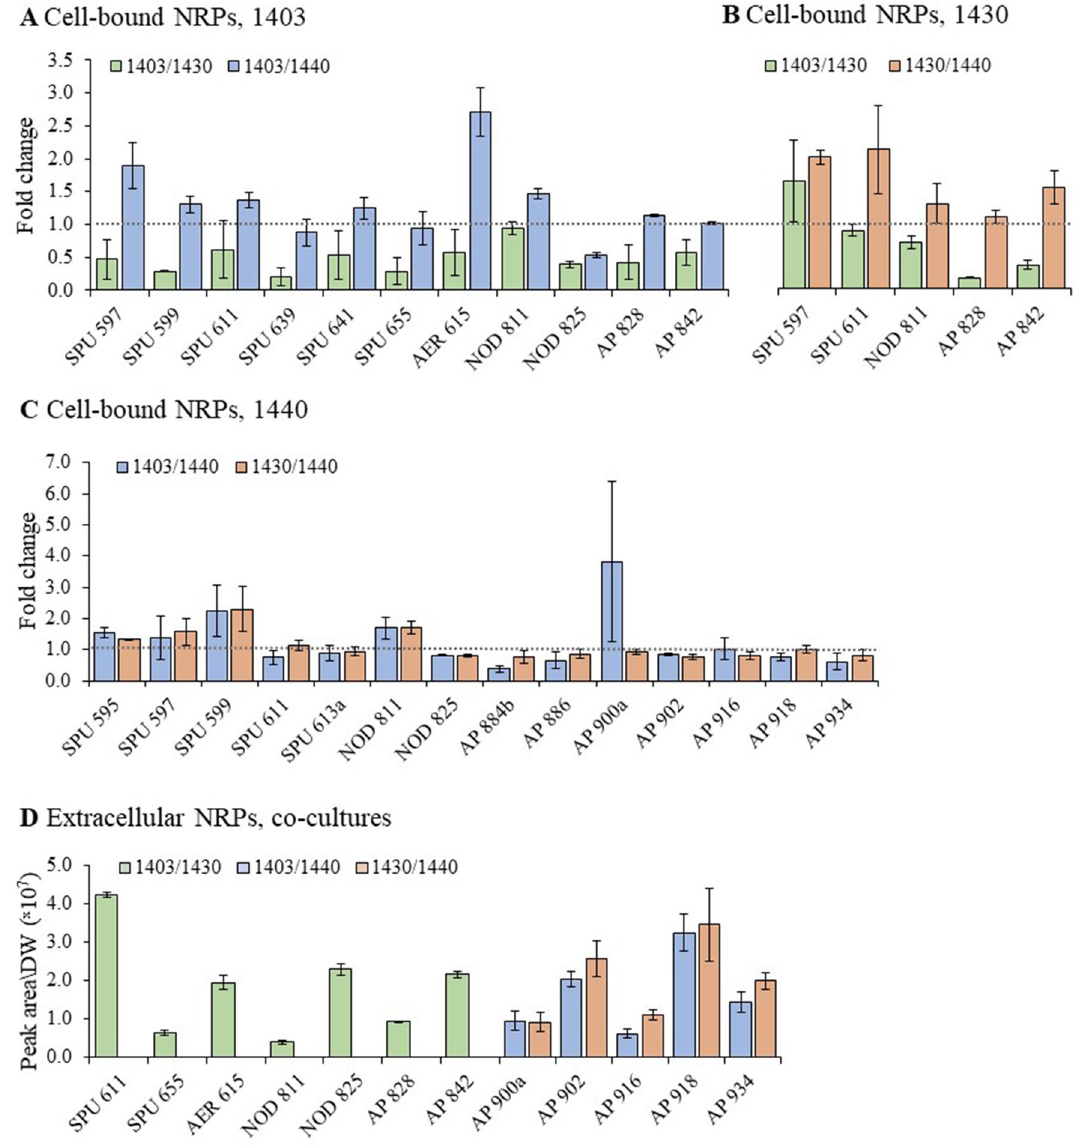
Figure 4. Relative concentrations of ( A ), 1403; ( B ), 1430; ( C ), 1440 cell-bound NRPs and ( D ) extracellular NRPs in co-cultures. Relative concentrations of cell-bound NRPs are given as a fold change over N. spumigena respective monocultures (mean ± standard error, n = 3). Grey dash-line represents onefold change, i.e. concentrations equal to monoculture. Relative concentrations of extracellular NRPs in co-cultures are given as dry weight normalized peak areas (mean ± standard error, n = 3). Note that no extracellular NRPs were detectable in monocultures of the same strains. Treatments: co-cultures 1403/1430 (green), 1403/1440 (blue) and 1430/1440 (orange). NRP classes are denoted as SPU, spumigins; NOD, nodularins; AER, aeruginosins and AP,